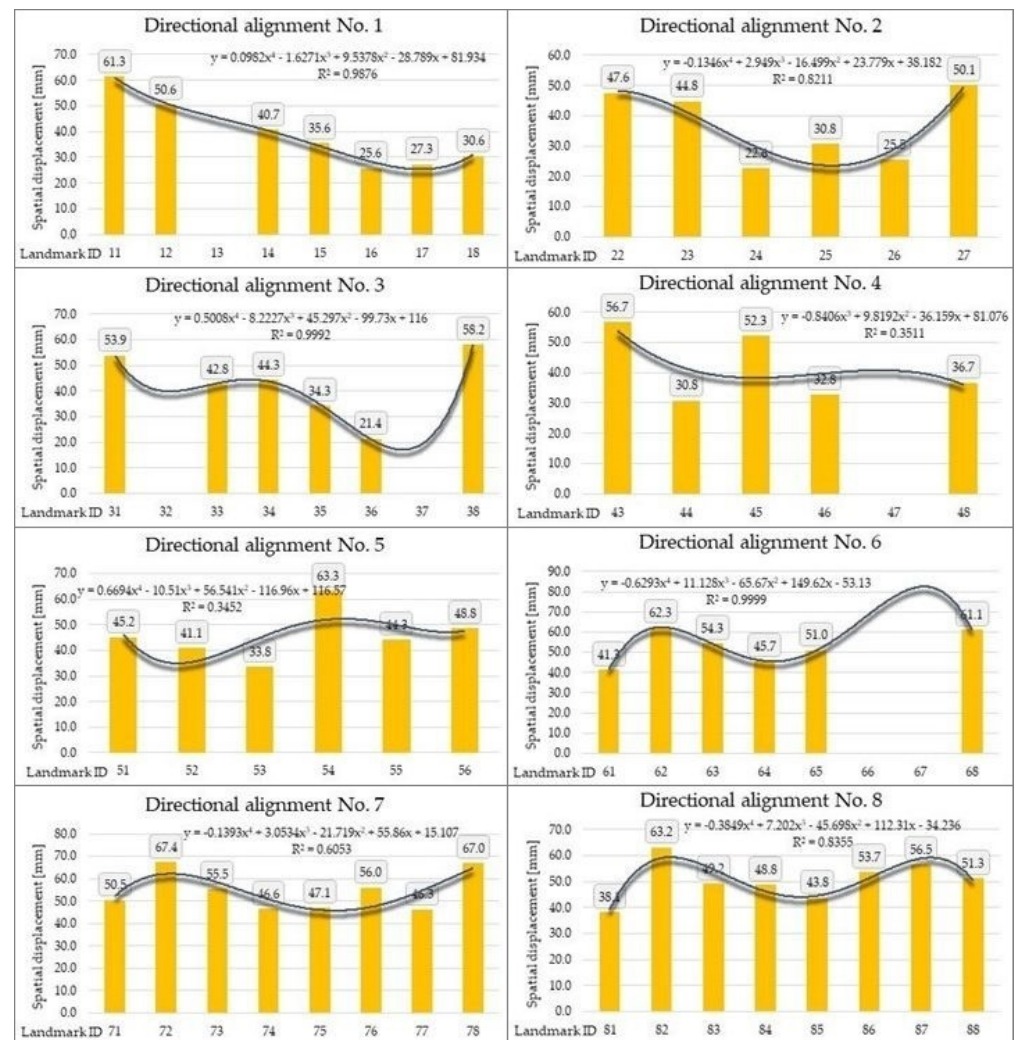
Figure 12. Linear displacements of each surveyed landmark on the eight directional alignments.